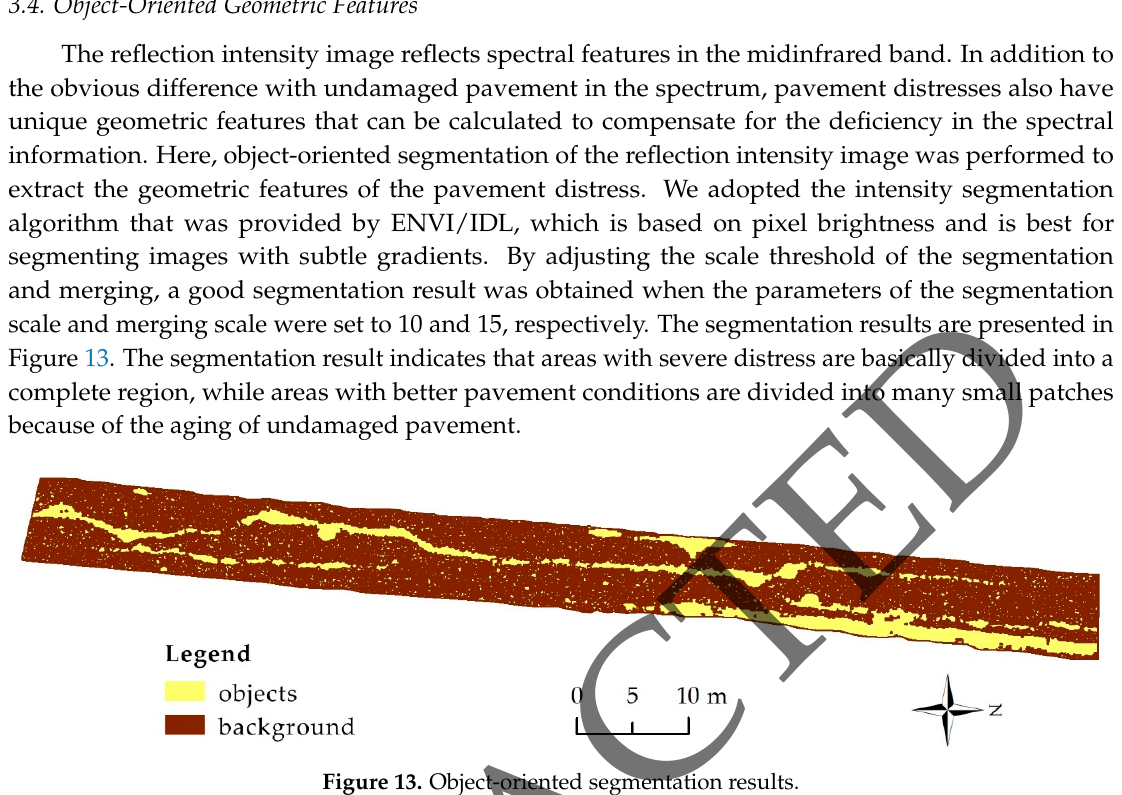
Figure 13. Object-oriented segmentation results.